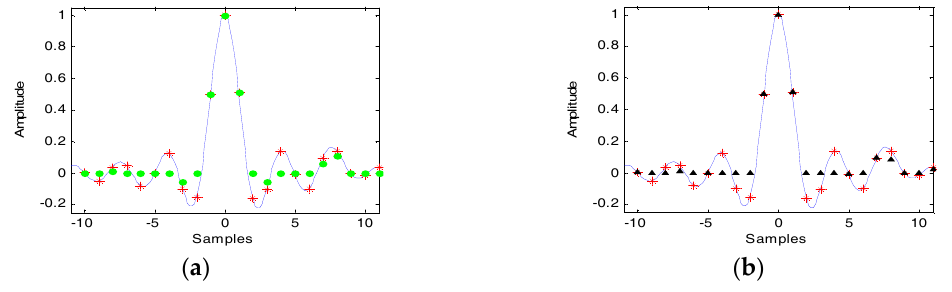
w  ). ( a ) SVA; ( b ) Additional SVA. s